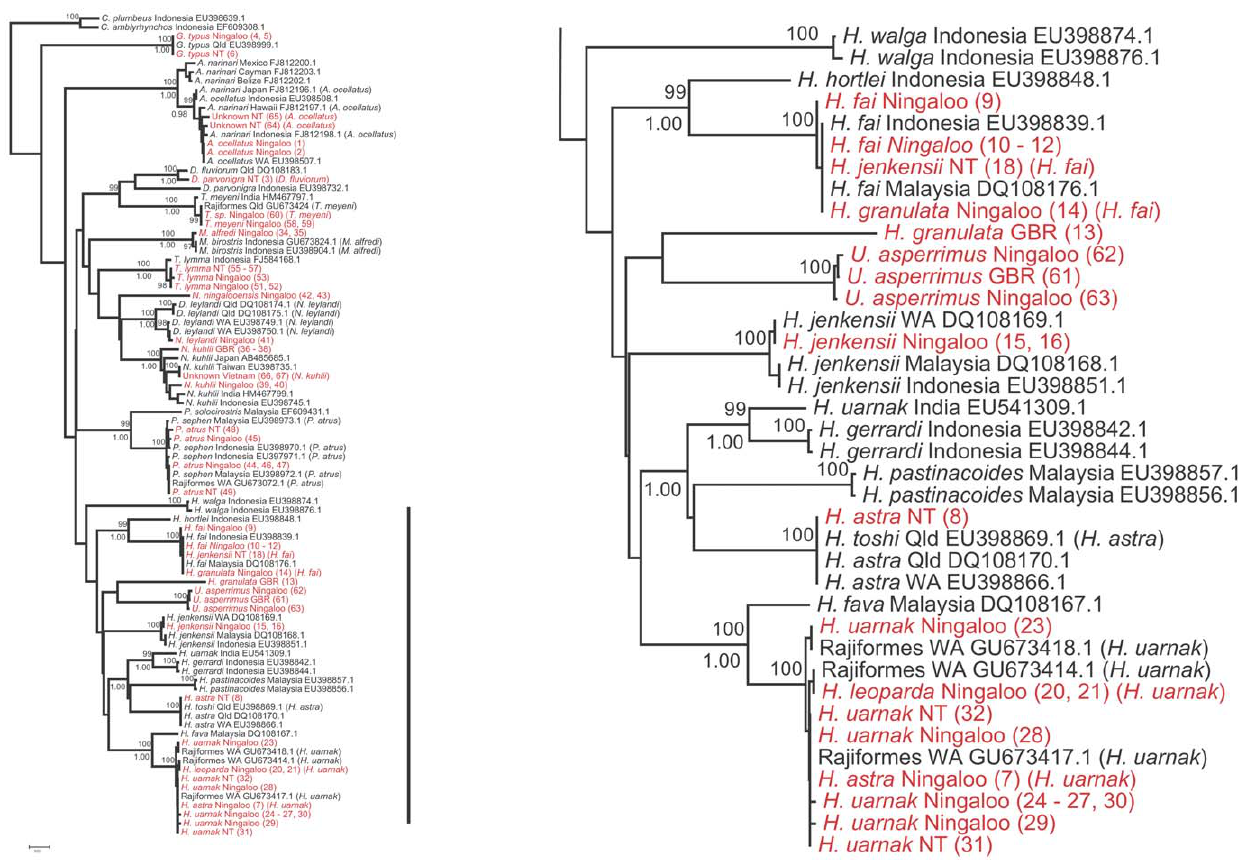
Figure 3. Phylogenetic relationship of rays Part III. Third part of the Neighbour-joining tree based on COI sequence data using Kimura-two- parameter substitution model (left); the third part of the tree (right). Names in red are the sequences obtained in this study, the corrected nomenclature is in () and given in Table S2.